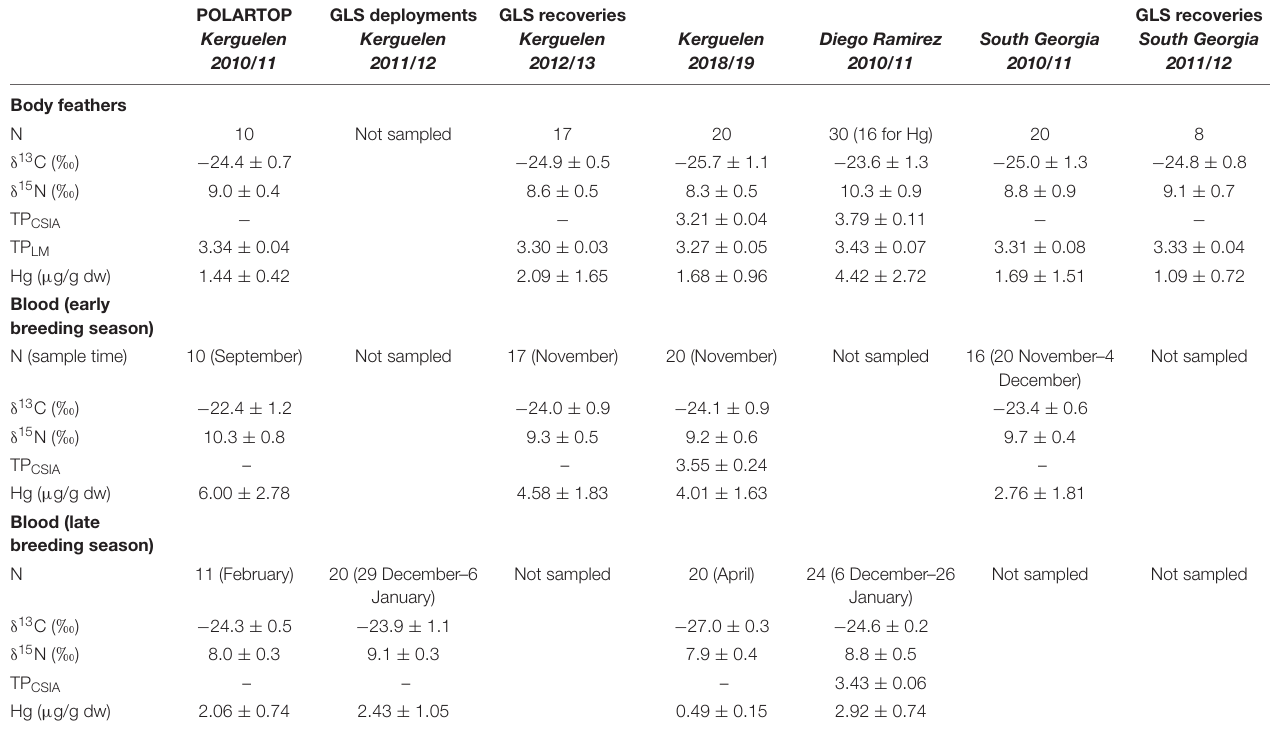
TABLE 1 | Summary of stable isotope and mercury data of Blue Petrels (mean ± standard deviation), as well as trophic position (TP) estimates based on linear models (TP LM ) or compound-specific isotope analyses of amino acids (TP CSIA